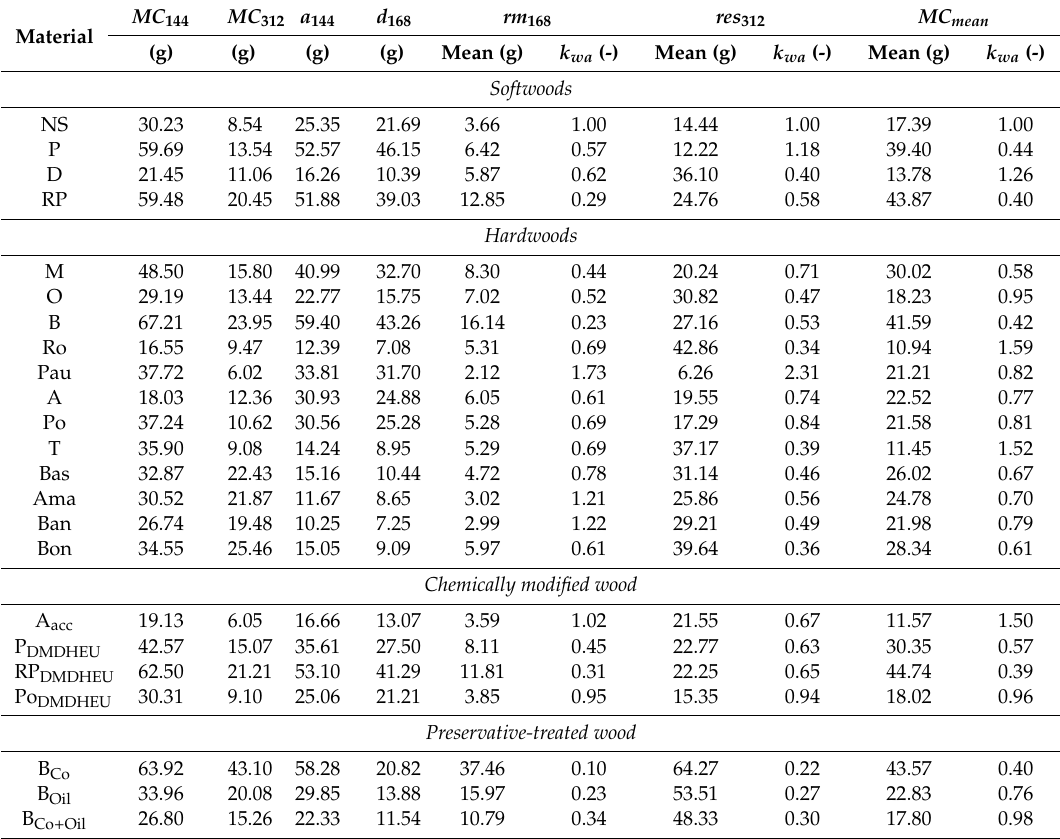
Table 4. Moisture content at the end of absorption ( MC 144 in g) and desorption cycle ( MC 312 in g), amount of absorbed moisture after 144 h ( a 144 in g), amount of desorbed moisture after 168 h ( d 312 in g), residual moisture content ( rm 168 in g), residue ( res 312 in g) and mean MC ( MC mean ) in submersion tests (150 (ax.) × 50 × 25 mm 3 ) according to